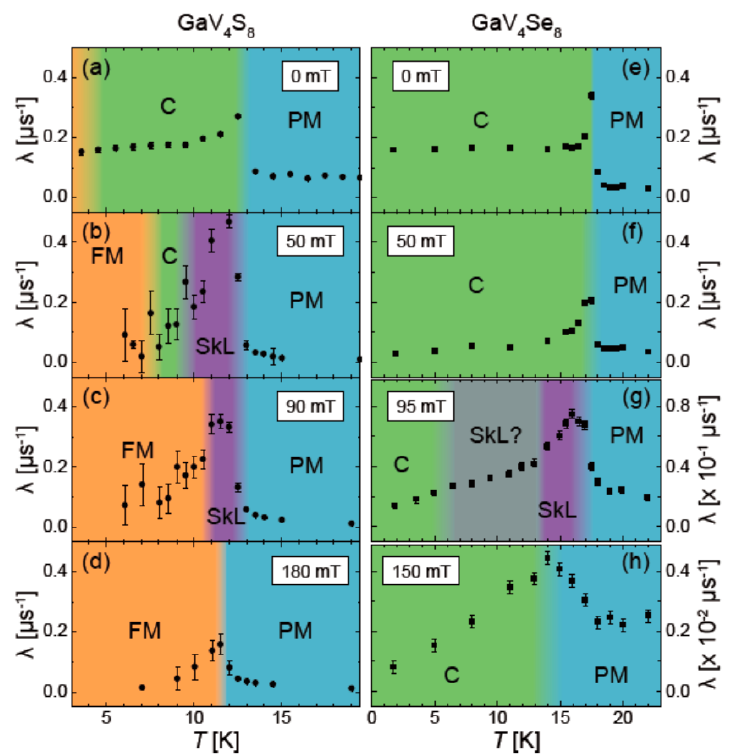
Figure 9. Results of fitting zero field (ZF) and longitudinal field (LF) data for GaV 4 Se 8 ( a – d for different field levels) and GaV 4 S 8 ( e – h for different field levels) [21].